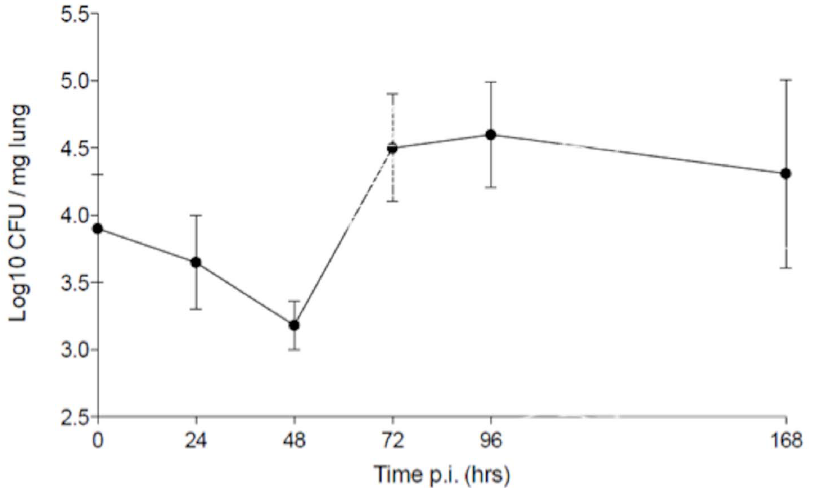
Figure 2. Kinetics of airway infection by P.aeruginosa LESB65. Mice were challenged [intranasal] with 10 6 CFU. Values shown as an average Log CFU/mg of lung tissue homogenised, n=5 mice at each time point. Time zero samples were taken at 15 minutes post infection to confirm entry into the lung and determine levels immediately post infection.